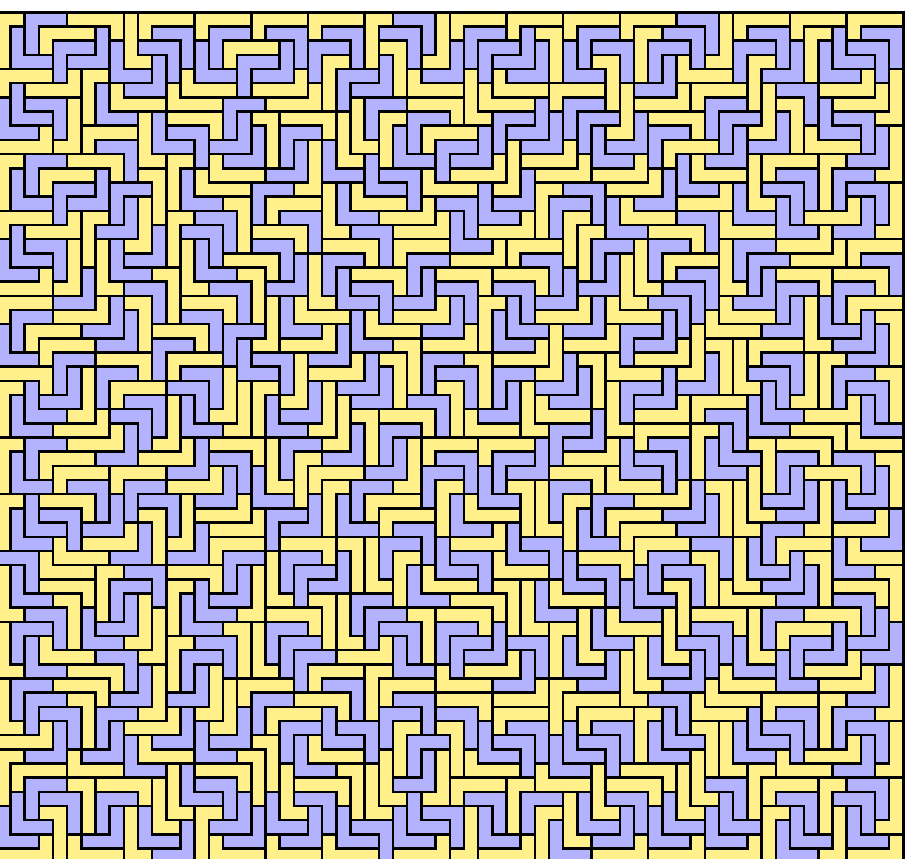
Figure 25. The tiling solution for Example 13 using 384 copies of the V-shaped pentomino, and 384 copies of the L-shaped pentomino. The optimal solution uses 384 copies of P − 384 copies of P + (coloured yellow). The target region (cid:98) R is a checkerboard coloured 60 × 64 rectangle 2 with the top left square